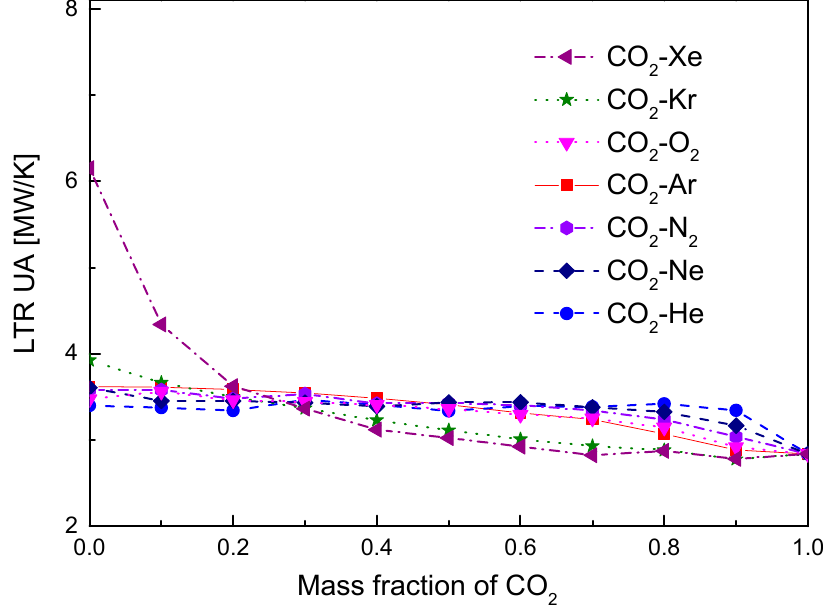
Figure 16. LTR conductance of mixtures at different mass fractions of CO 2 .